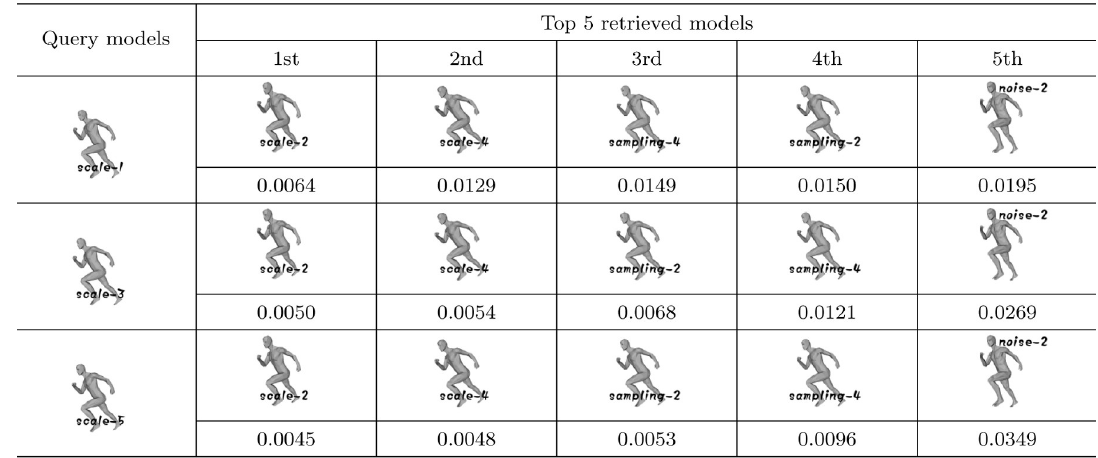
Table 2. The query results of scaling invariance